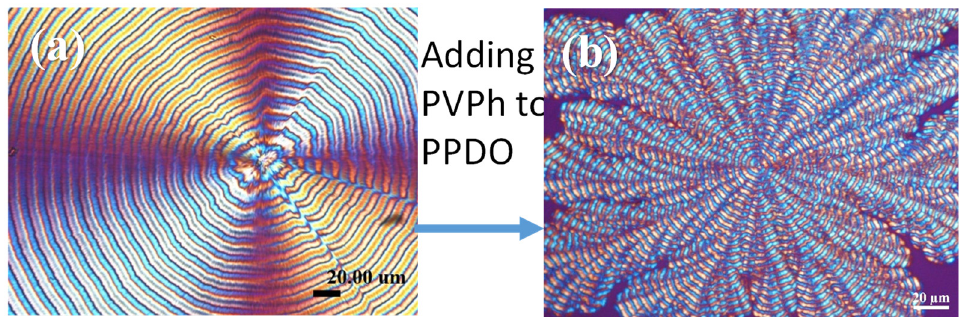
Figure 1. POM graphs of ( a ) neat PPDO vs. ( b ) PPDO in PPDO/PVPh blend (75/25), both at T c = 78 °C for a period of 3–4 days till full crystallization.